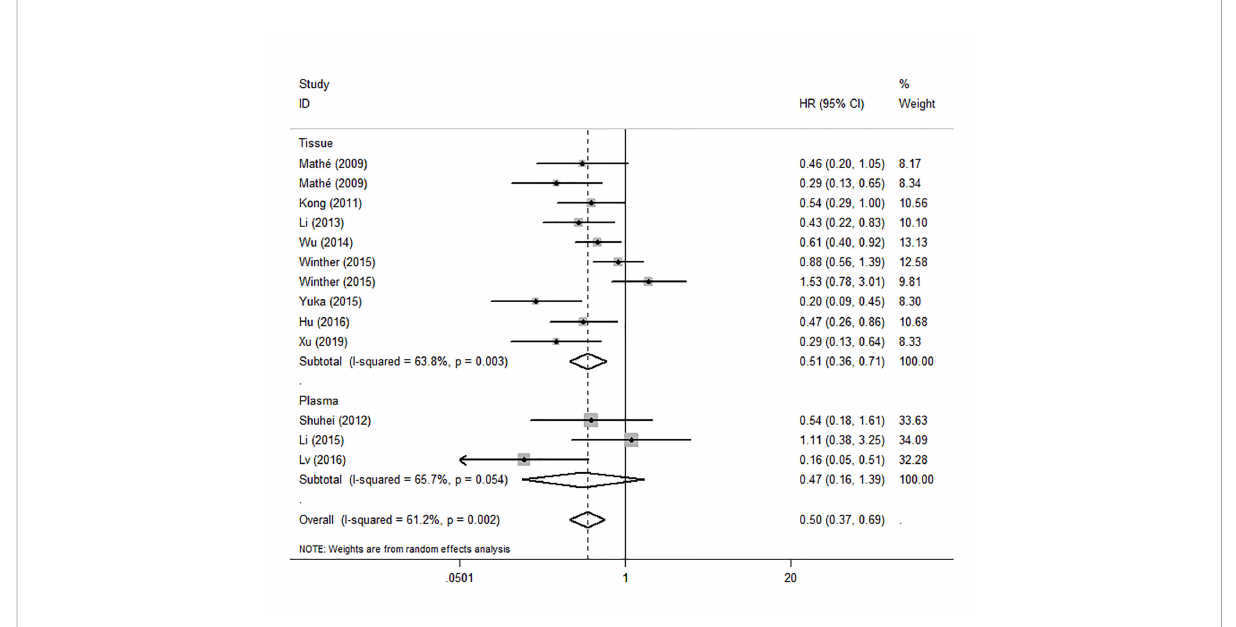
FIGURE 8 Forest plot showing subgroup analysis of the selected studies about the prognostic signi fi cance of mir-375 in patients with different sample